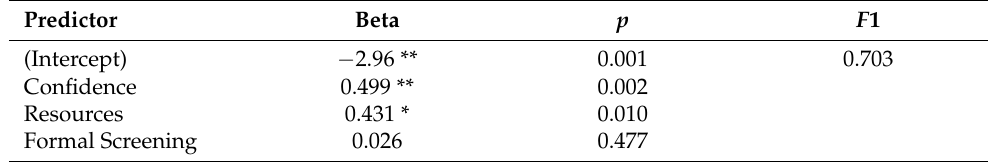
Table 4. H1: PCC Beliefs Regression.